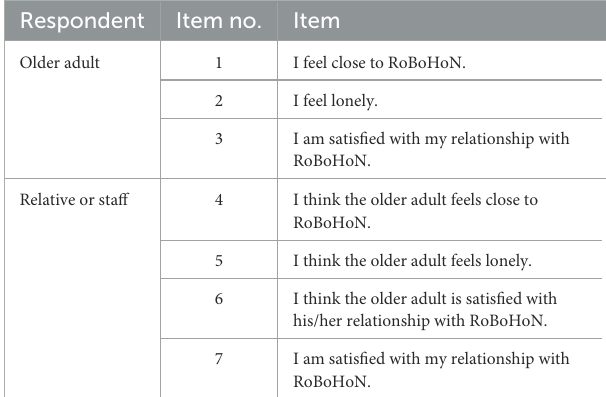
could reply with simple jokes. It could also sing and dance using its arms and head. This robot has been used to promote older adult participants’ conversation with the purpose of maintaining their mental health through conversation and gathering various data, including a dialogue corpus, to improve the conversational functions of the